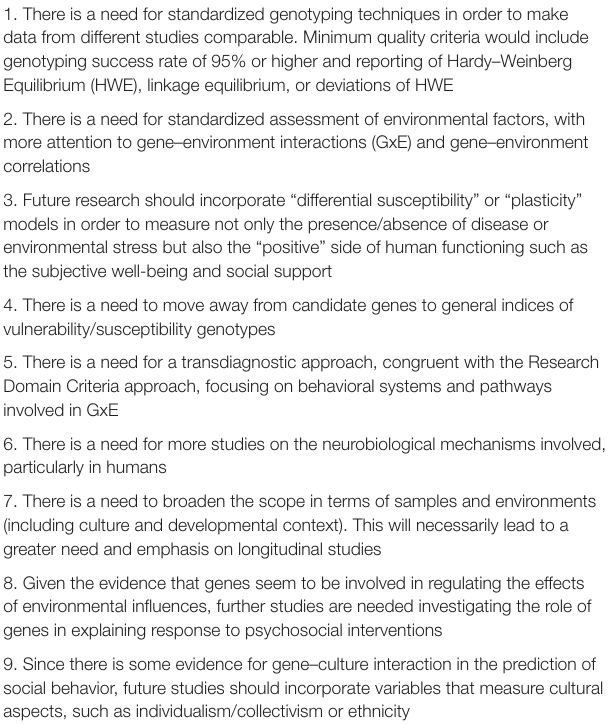
TABLe 2 | Recommendations for future research.